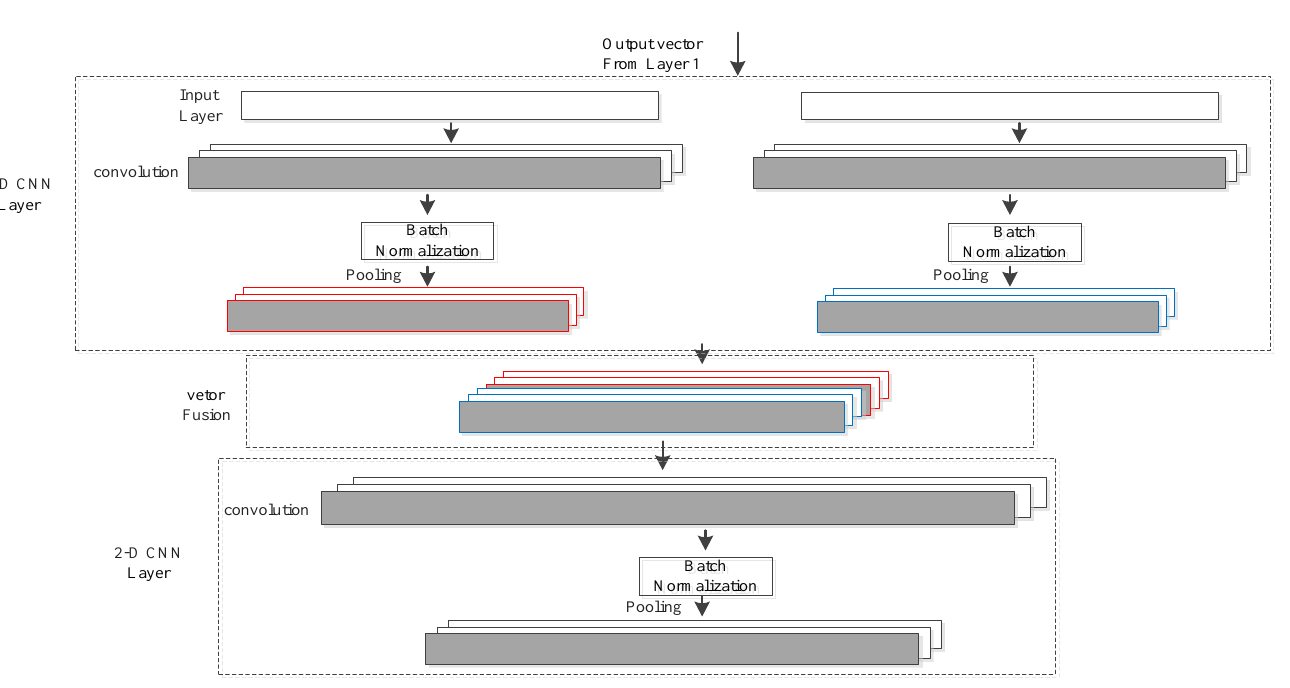
Figure 3. Feature extraction of multi-channel sensor signals.